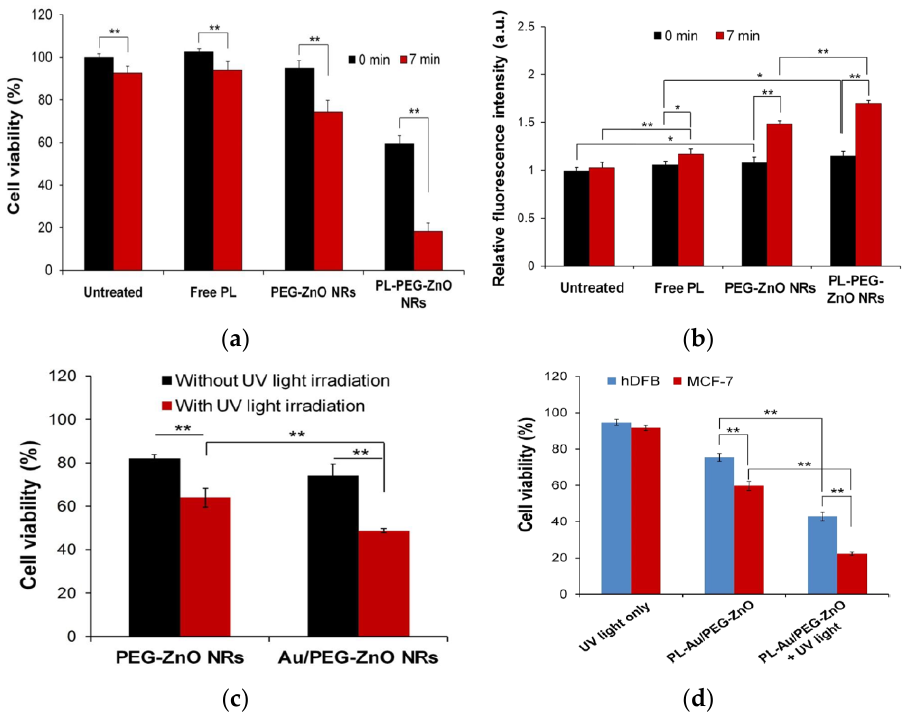
Figure 32. ( a ) MTT assay-cell viability and ( b ) relative ROS generation in MCF-7 cells treated with free PL (0.55 μM), PEG-ZnO NRs (20 μg/mL), and PL-PEG-ZnO NRs (20 μg/mL) with or without UV irradiation for 7 min. * p < 0.05 and ** p < 0.01. ( c ) Viability of MCF-7 cells treated with PEG-ZnO NRs